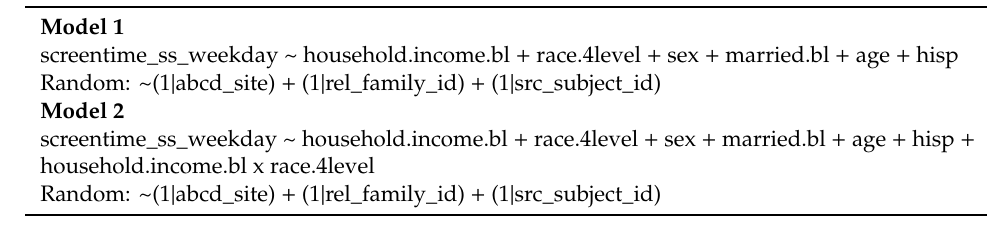
Table 1. The model formulas.